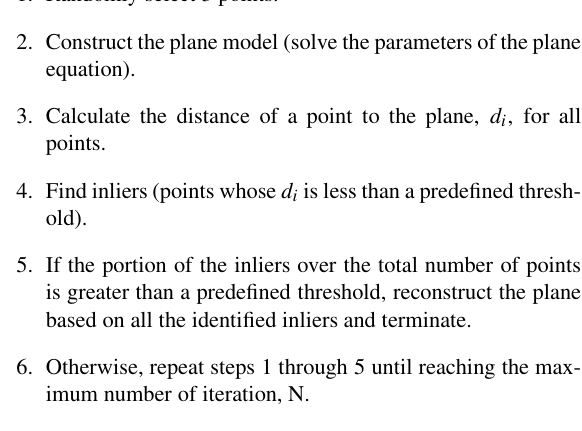
Algorithm 1 RANSC for plan fitting from LiDAR point clouds